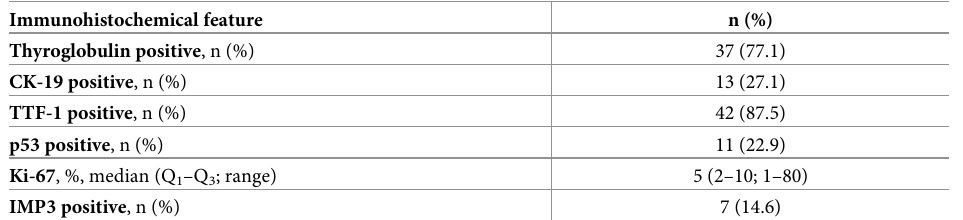
Table 2. Immunohistochemistry in poorly differentiated thyroid cancer (n =